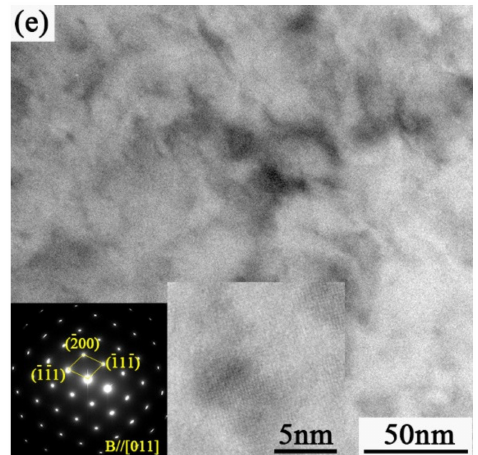
Figure 7. Bright field images and high-resolution transmission electron microscopy (HRTEM) images of the Al-7Si-0.55Mg alloy after aging treatment at di ff erent conditions: ( a ) 10 Hz, 300 A; ( b ) 10 Hz, 1200 A; ( c ) 40 Hz, 300 A; ( d ) 40 Hz, 1200 A and ( e ) conventional heat treatment.